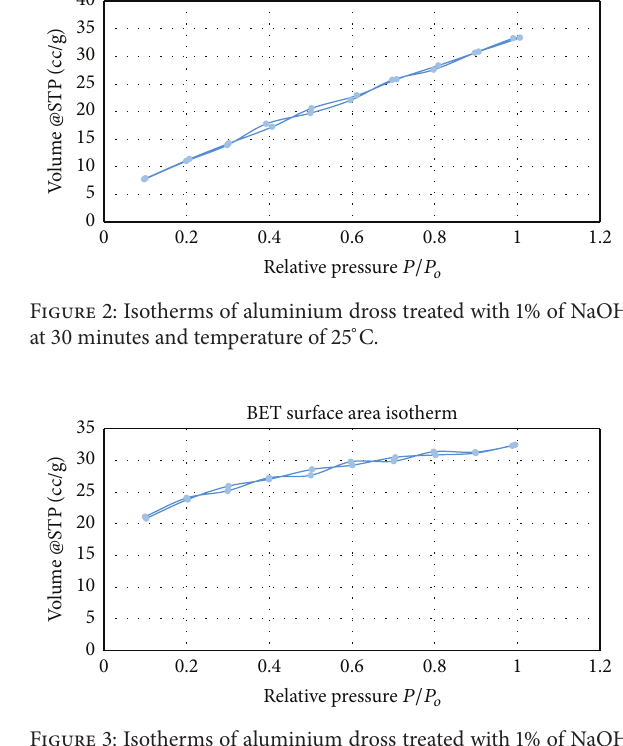
Figure 3: Isotherms of aluminium dross treated with 1% of NaOH at 30 minutes and temperature of 40 ∘ C.